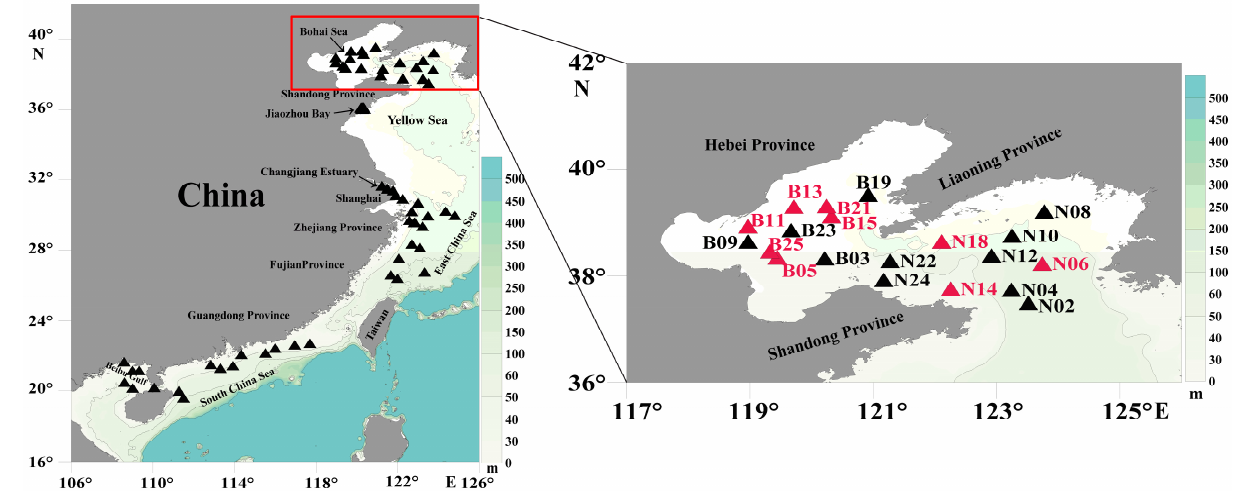
Figure 2. Geographical distribution of environmental samples used in this study. The environmental samples are marked by triangles. The results of positive amplified samples are marked by red shapes.